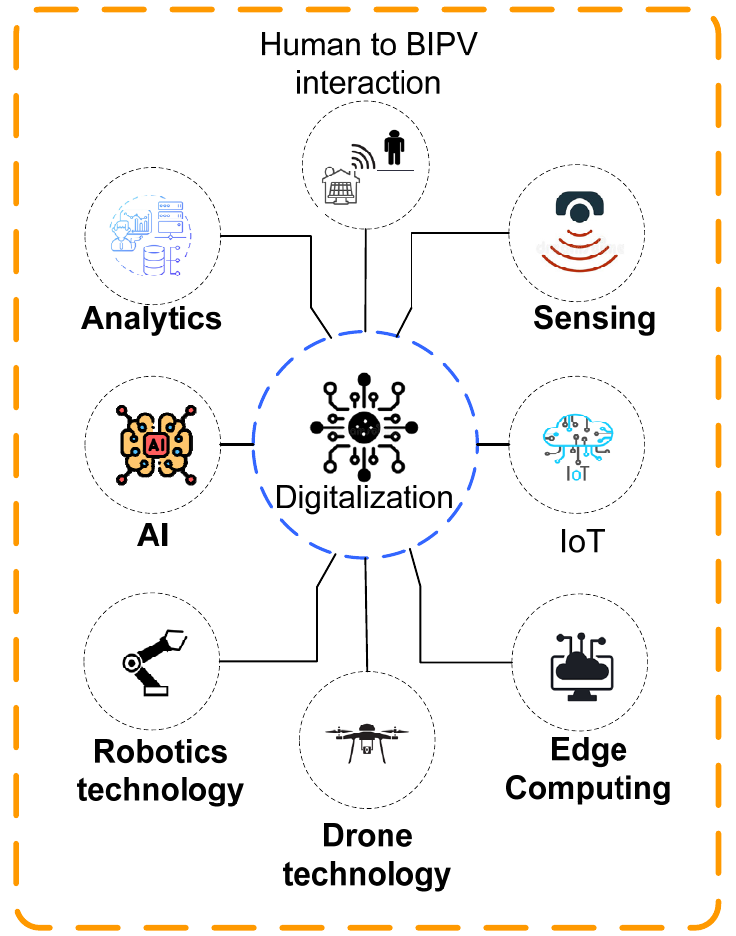
Figure 7. Digitalization in the BIPV system.